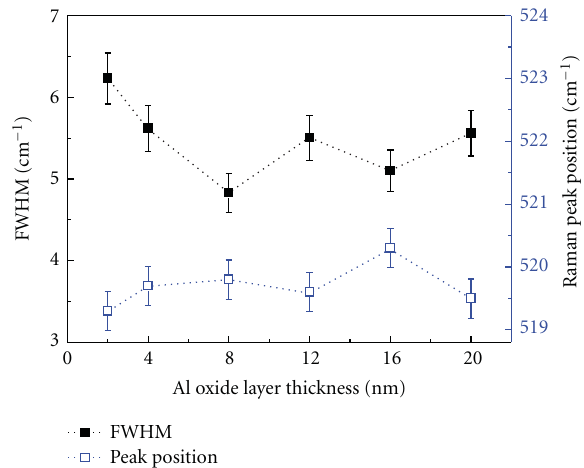
Figure 5: FWHM and Si peak of poly-Si films as a function of the Al oxide